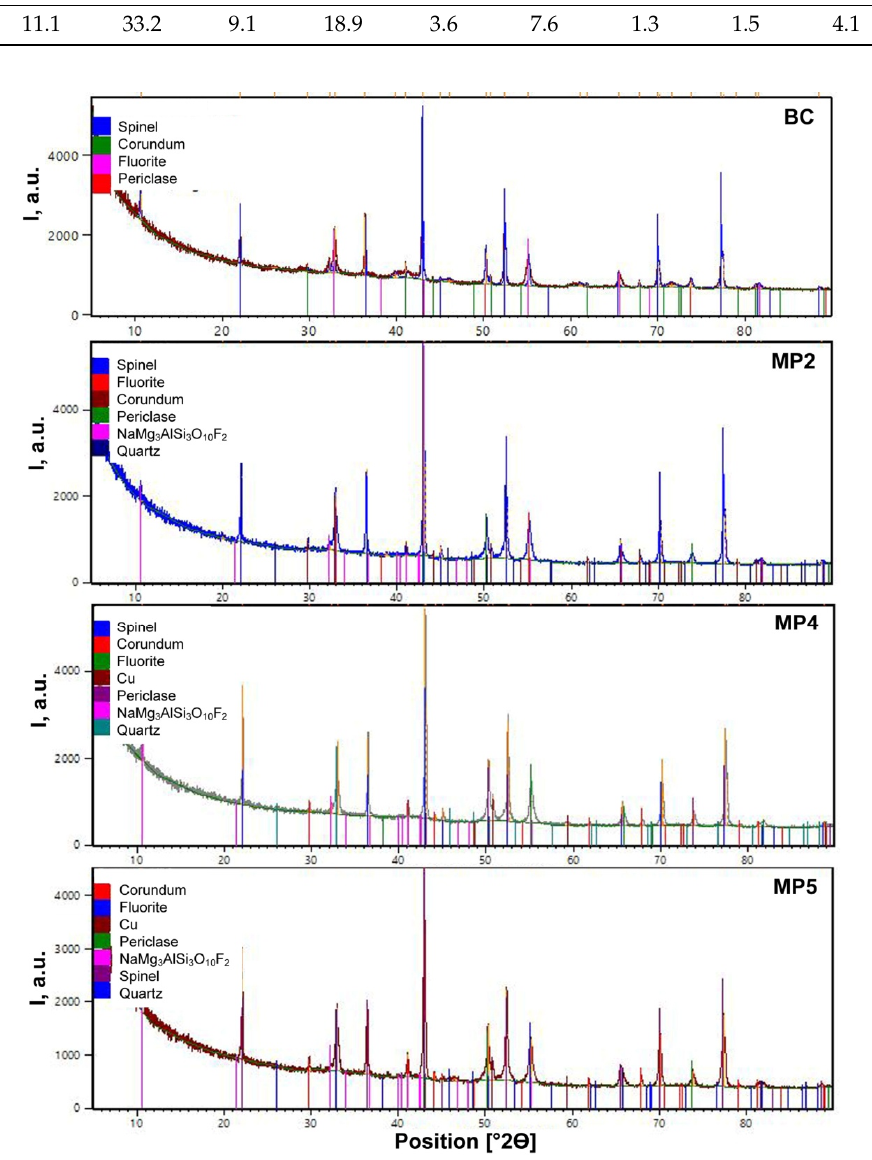
Figure 1. Analysed XRD patterns of post-weld slags in Table